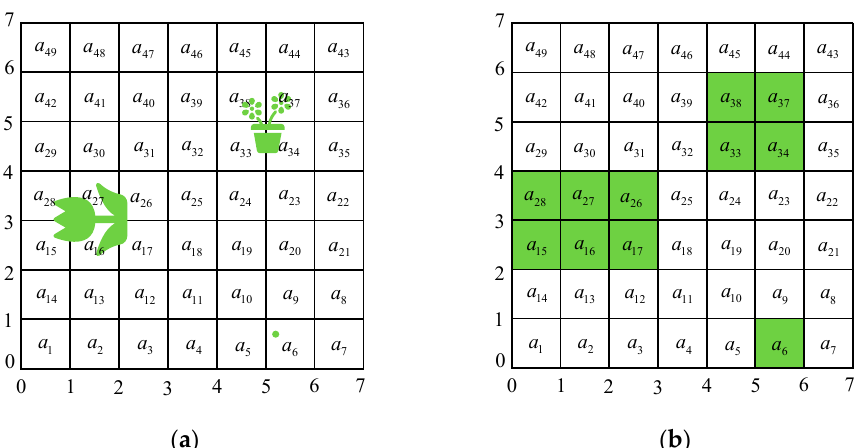
Figure 4. Flow chart of improved A* algorithm.